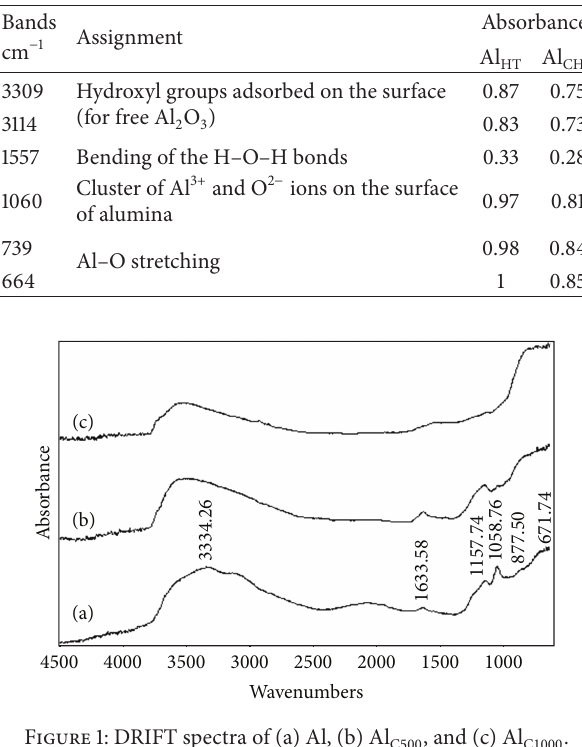
Table 4: DRIFT bands that are characterizing hydrothermally treated alumina samples.